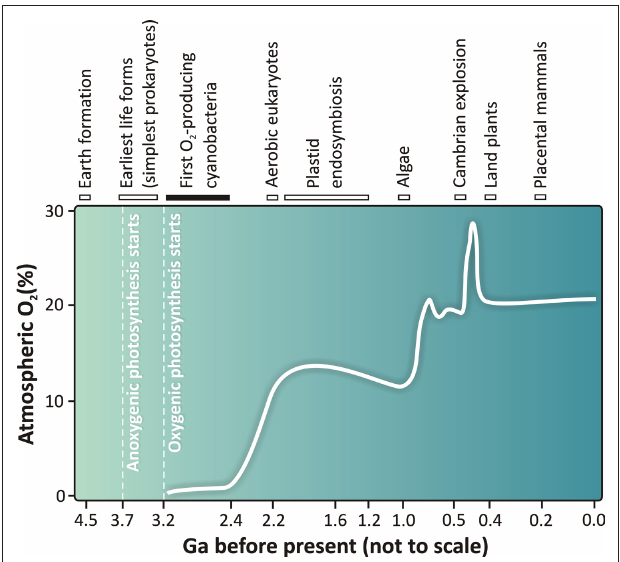
FIgurE 1 | A schematic view of the changing concentration of atmospheric oxygen as a function of geological time in billions of years (ga). Correlation between the estimated oxygen concentration changes and the major evolutionary events on Earth are based on data presented by Falkowski (2006; 2011), Tomitani et al. (2006), Kump (2008), Blankenship (2002; 2010), and Hohmann-Marriott and Blankenship (2011). The dates in the figure are not to scale and are approximations. Uncertainties of the selected events in the evolution of life are depicted with bars. A number of hypotheses exist as to when oxygenic photosynthesis was invented, by primitive cyanobacteria-like organisms. In this scheme, we have summarized currently available data and depict (by a black bar) that the first cyanobacteria could have evolved as early as 3.2 Ga or as late as 2.4 Ga ago. Therefore, an upper boundary of 3.2 Ga for the age of oxygenic photosynthesis and the initial rise of atmospheric oxygen in the atmosphere as indicated in this figure is still under discussion in the literature (see e.g., Tomitani et al., 2006; Allen and Martin, 2007; Blankenship et al., 2007; Buick, 2008). The figure is modified and adapted from Shevela and